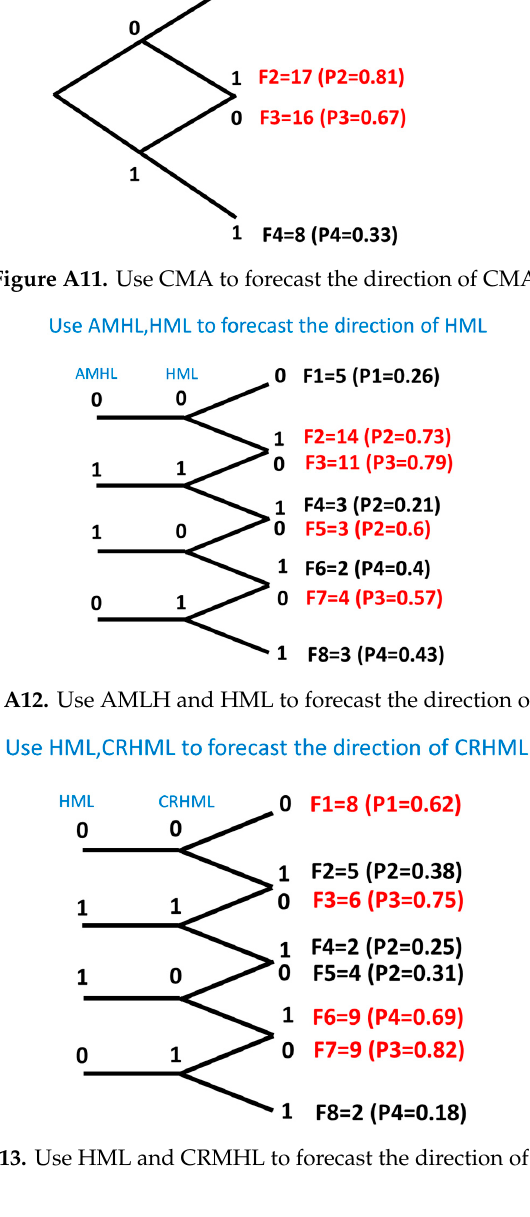
Figure A14. Use RMW and AMLH to forecast the direction of AMLH.